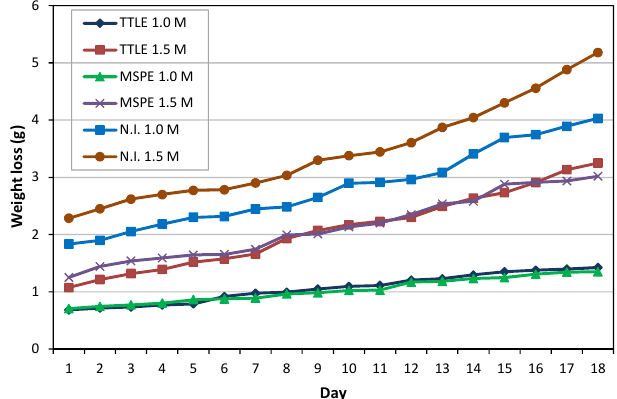
Fig. 2. Plot showing weight loss against time at room temperature.